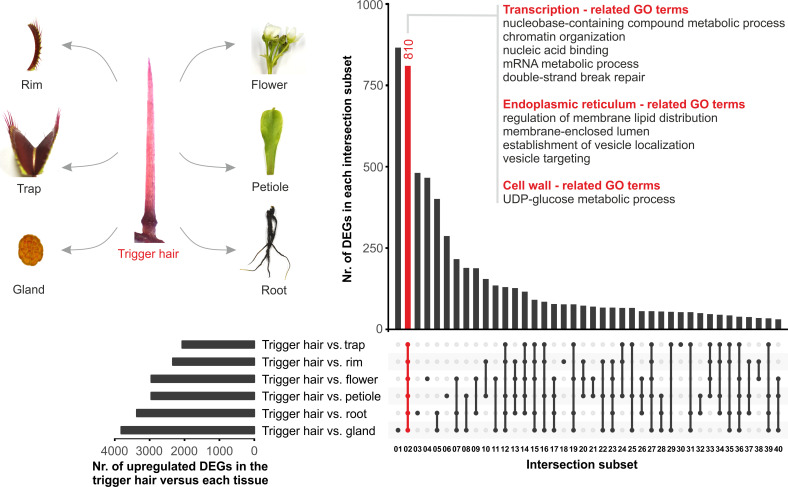
A high number of genes are highly expressed in the trigger hair.Of note, the expression of 810 DEGs is elevated by a factor of at least 2 in the trigger hairs compared to all of the other tissues such as trap, rim, flower, petiole, root, and gland tissues (log2FC > 1, BH adjusted p-value < 0.001, trigger hair normalized counts > 50). Enriched GO terms for subset02 (810 genes, red bar, representing trigger hair vs. all tissues) of the intersection analysis between DEGs groups are shown (GO enrichment, BH adjusted p-value < 0.05). Underlying full raw dataset is provided in S1 Data. BH, Benjamini–Hochberg; DEG, differentially expressed gene; GO, gene ontology; UDP-glucose, uridine diphosphate glucose.